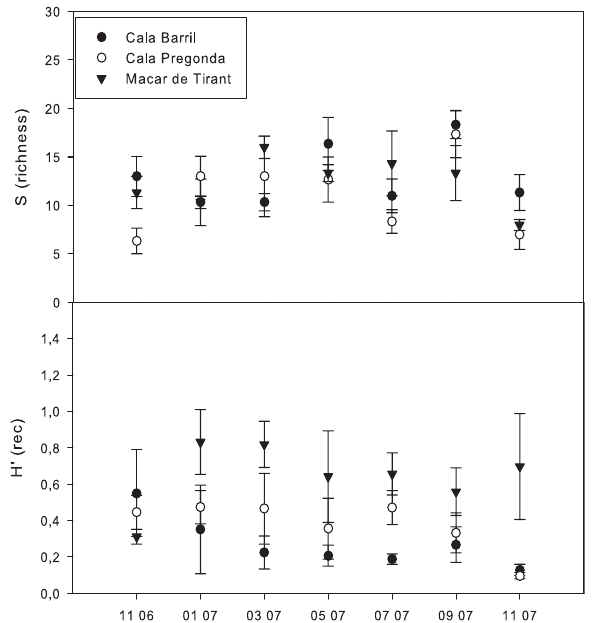
: biomass (g dwt m –2 ) at the end of the period, B 2